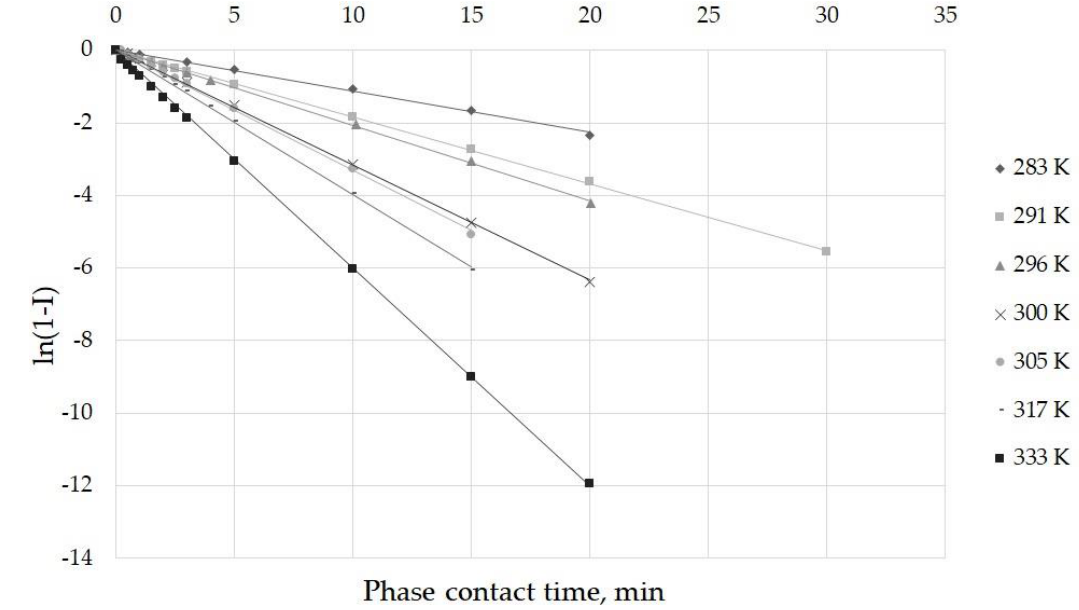
Figure 8. The logarithmic dependences of the degree of approaching to iron (III) extraction equilibrium on the temperature. Table 3. The values of the angular coefficients—rate constants of the yttrium and iron (III) extraction process.